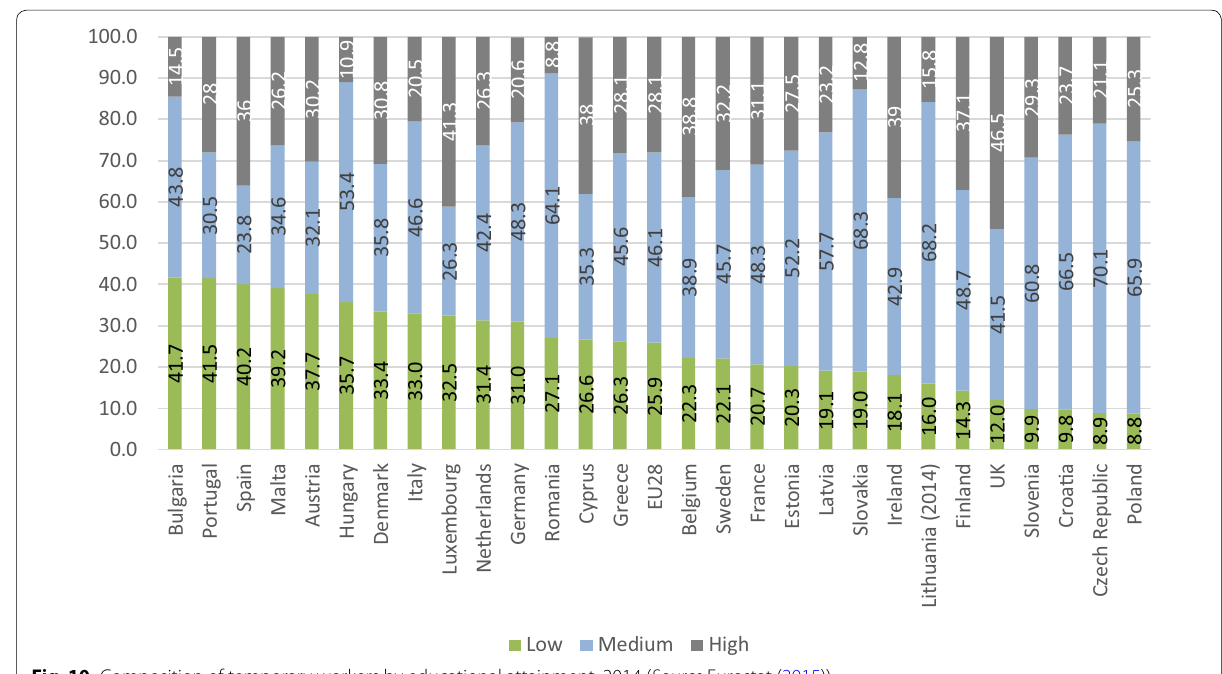
Fig. 10 Composition of temporary workers by educational attainment, 2014 ( Source Eurostat